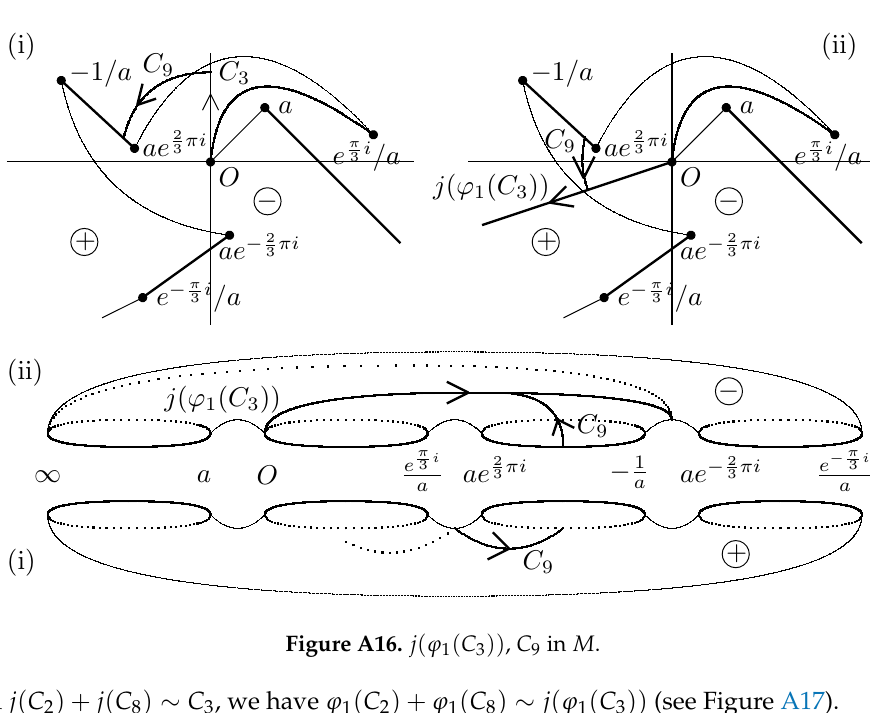
Figure A16. j ( ϕ 1 ( C 3 )) , C 9 in M .